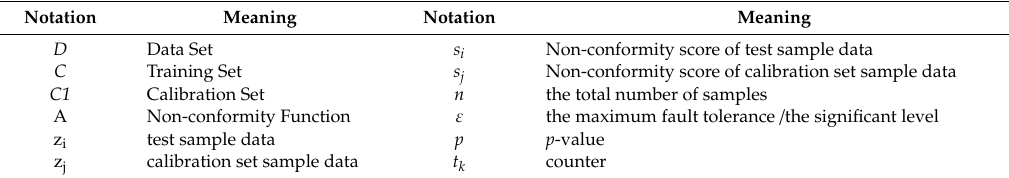
Table 2. List of notations in the Conformal Prediction